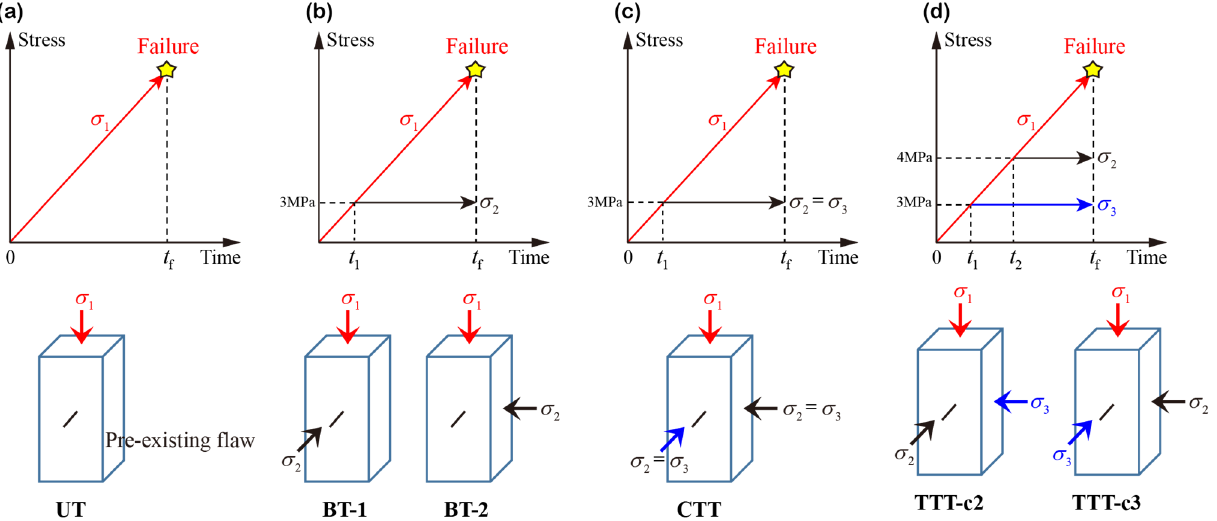
Figure 3. Different test schemes of rock: ( a ) uniaxial test (UT); ( b ) biaxial test (BT), divided into two types: BT − 1 and BT − 2; ( c ) conventional triaxial test (CTT); ( d ) true triaxial test (TTT), divided into two types: TTT − c2 and TTT − c3.